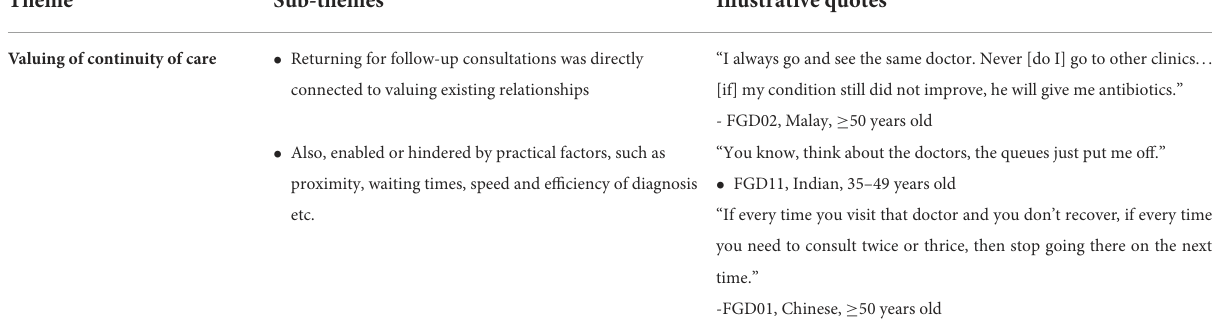
TABLE 3C Continuity of care, themes collated from focus group discussion